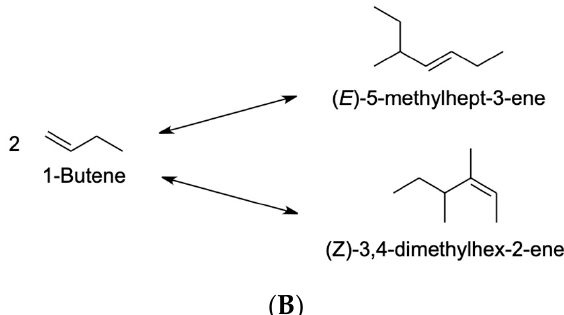
Figure 15. ( A ) Reaction mechanism of glycerol etherification with 1-butene [62]; ( B ) Reaction mechanism of dimerization of 1-butene [62].